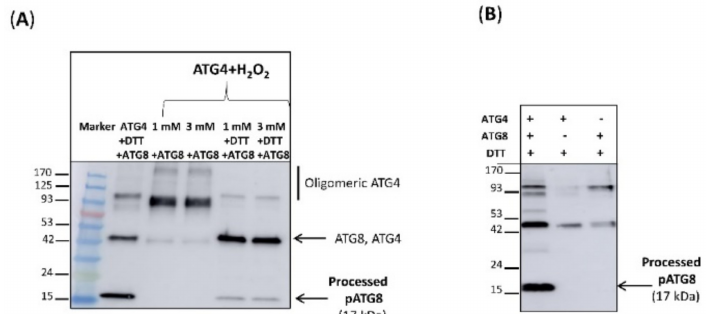
Figure 12. Regulation of ATG4 activity by oxidation and reduction. ATG4 activity was monitored by following the cleavage of recombinant quimeric His tag ATG8 substrate from the unprocessed to the processed pATG8 forms (indicated by arrowheads) by Western blot analysis using anti-His antibody. ( A ) His tag HsATG4B was incubated with DTT (lane 2), 1 mM (lane 3) and 3 mM (lane 4) of H 2 O 2 , and 1 mM or 3 mM H 2 O 2 followed by DTT (lanes 4 and 5, respectively) prior to their incubation with the substrate quimeric ATG8. Marker (M) proteins were loaded in lane 1. ( B ) Control experiment for the activity of recombinant His-tag protein ATG4 in the presence of His-ATG8-Fc (lane 1) and negative controls with only His-ATG4 or His-ATG8-Fc proteins (lanes 2 and 3, respectively) after the DTT treatment (see Material and methods section for